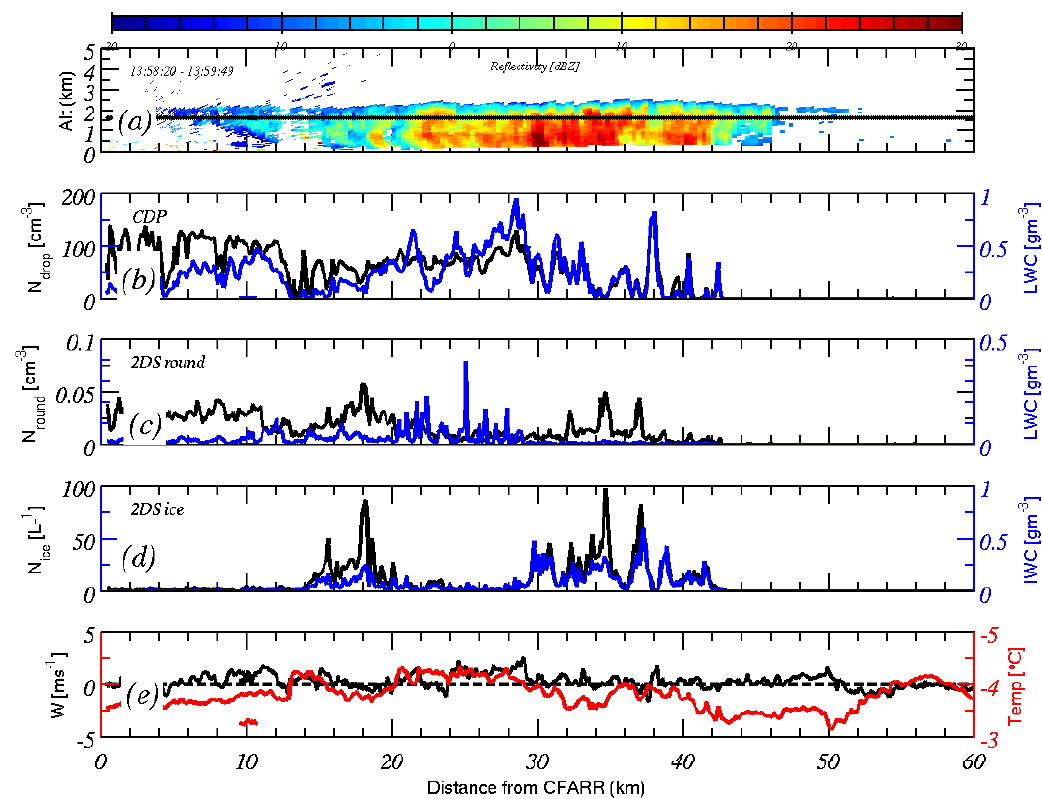
Fig. 5. Same as Fig. 4 but for Run R3, inbound to